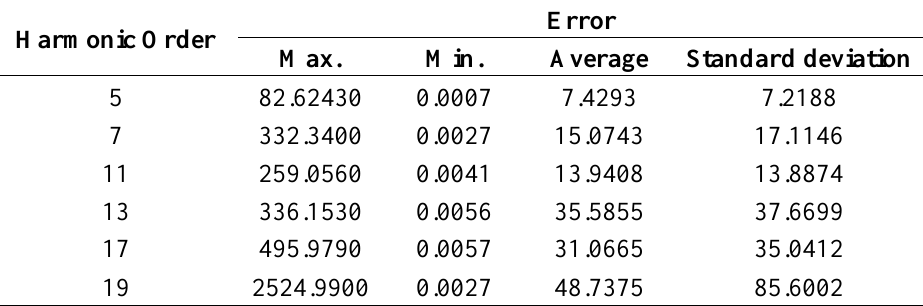
Table 2. Prediction results of ARMA (1,1).